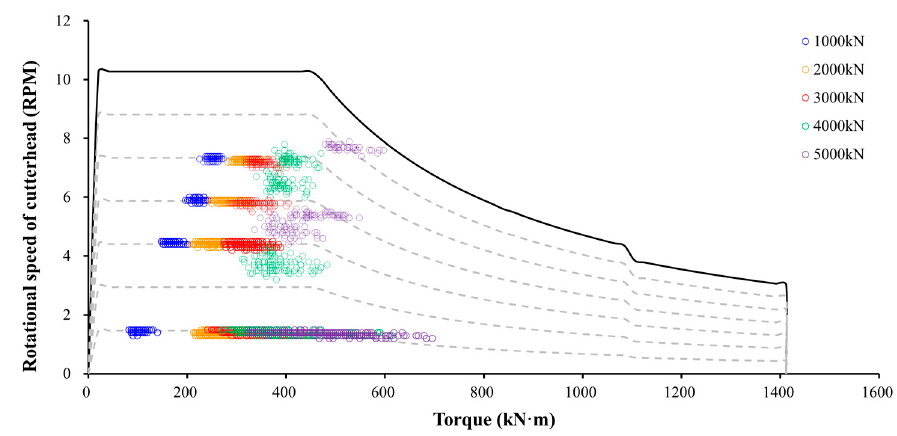
Figure 4. Cutterhead drive capacity expressed by relationships between torque and rotational speed of cutterhead.